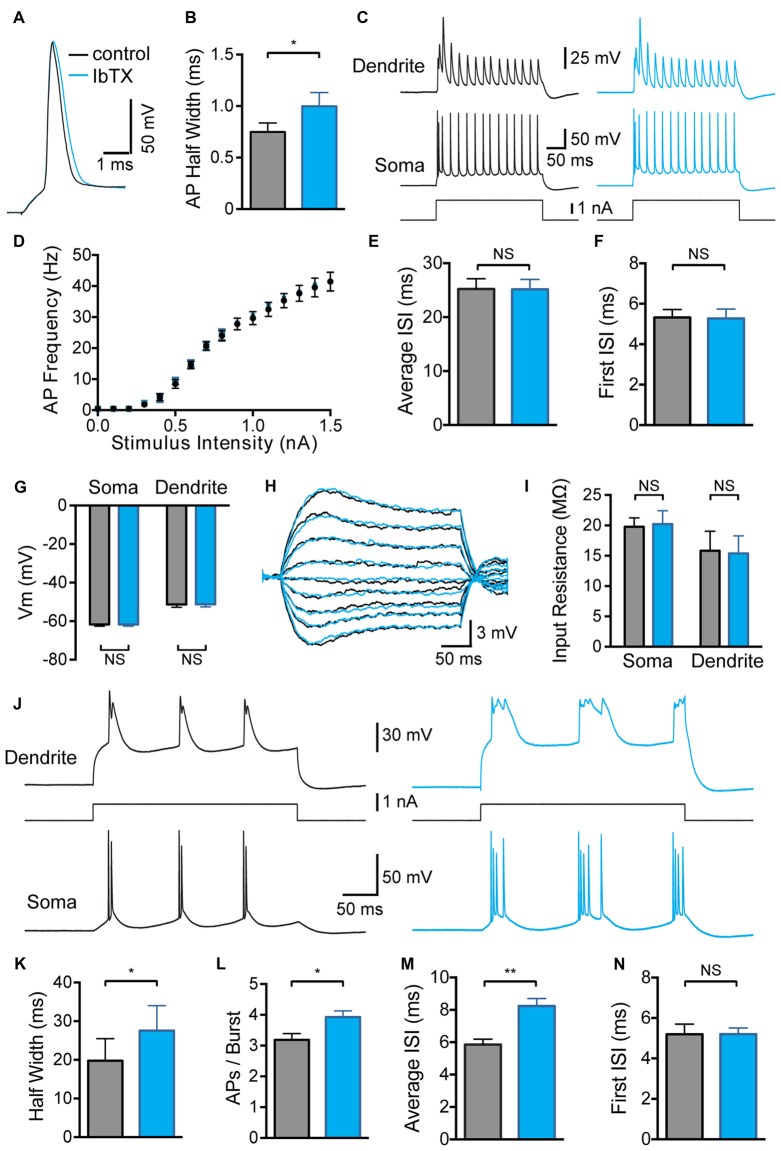
Effect of global large conductance calcium-activated potassium channels (BK channel) block on active and passive properties. (A) Single somatic action potential (AP) before (black) and after (blue) bath application of Iberiotoxin (IbTX). (B) Average half width of somatic APs before (black) and after (blue) block of BK channels by bath application of IbTX (n = 7). (C) Somatic and dendritic responses (660 μm from the soma) to somatic current injection before (black) and after (blue) bath application of IbTX. (D) Average F-I curve before (black) and after (blue) bath application of IbTX (n = 7). (E,F) Average inter-spike interval (ISI) between all somatic APs (E) or just the first two somatic APs (F) during a somatic current step injection of 1.5 nA before (black) and after (blue) bath application of IbTX (n = 7 cells). (G) Average resting membrane potential at the soma and dendrite recording site (600–800 μm from soma) before (black) and after (blue) bath application of IbTX. (H) Responses to sub-threshold current injections (−0.4 to +0.4 nA in steps of 0.1 nA) into the soma of an layer 5 (L5) pyramidal neuron before (black) and after (blue) bath application of IbTX. (I) Average input resistance at the soma and dendrite recording site (600–800 μm from soma) before (black) and after (blue) IbTX application (n = 7 cells). (J) Somatic and dendritic responses (660 μm from the soma) to dendritic current injection before (black) and after (blue) bath application of IbTX. (K) Average half width of dendritic calcium spikes before (black) and after (blue) block of BK channels by bath application of IbTX (dendritic recording site 600–800 μm from soma; n = 7). (L) Average number of APs per burst before (black) and after (blue) bath application of IbTX (n = 7). (M,N) Average ISI between all somatic APs (M) or just the first two somatic APs (N) during AP bursts evoked by dendritic current injections of 1.2 nA before (black) and after (blue) bath application of IbTX (n = 7 cells).